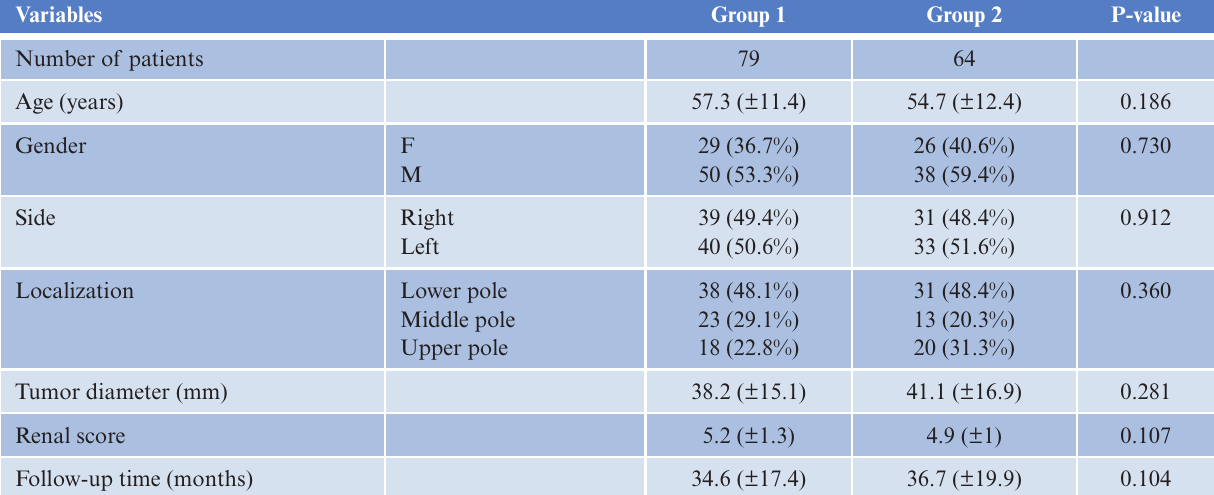
Table 1: Demographic and radiologic parameters of the